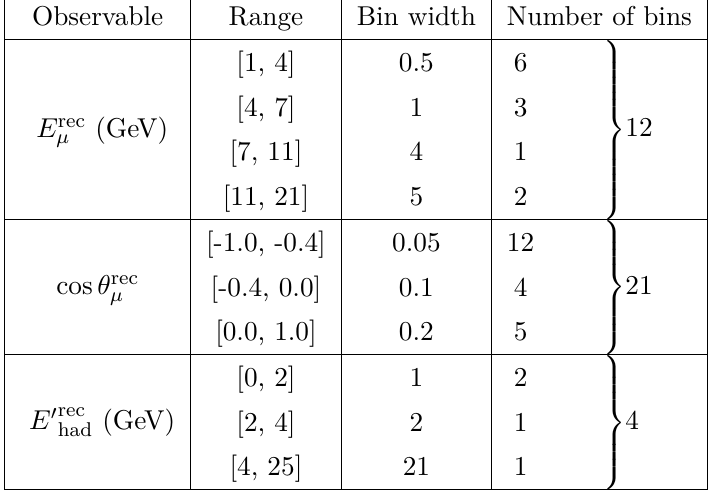
Table 5 . The binning scheme considered for reconstructed observables E rec µ − as well as µ +